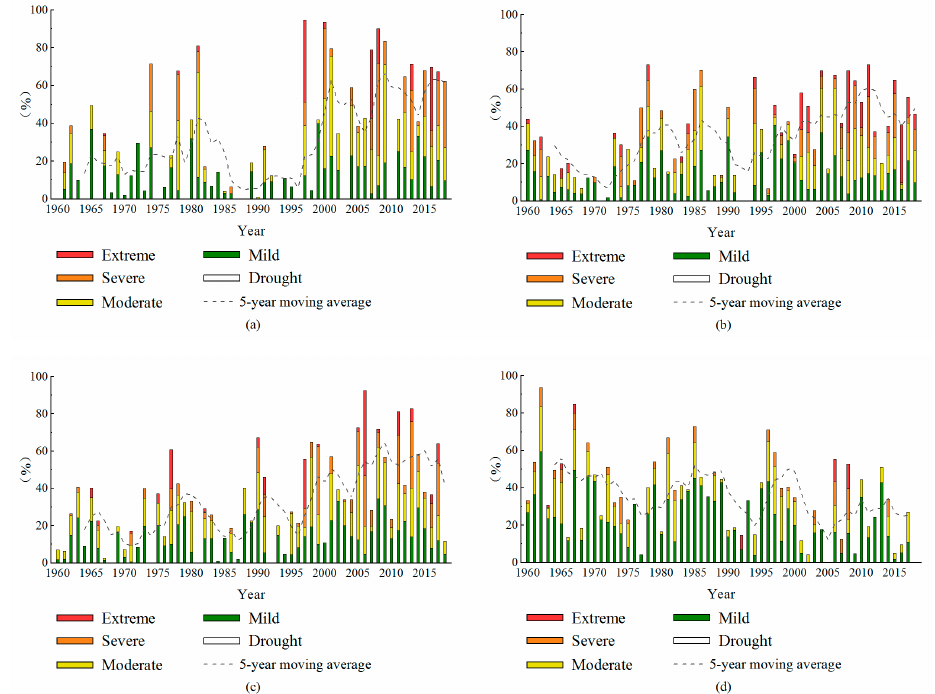
Figure 7. The changes of arid area ratio over the years, in spring ( a ), summer ( b ), autumn ( c ) and winter ( d ).